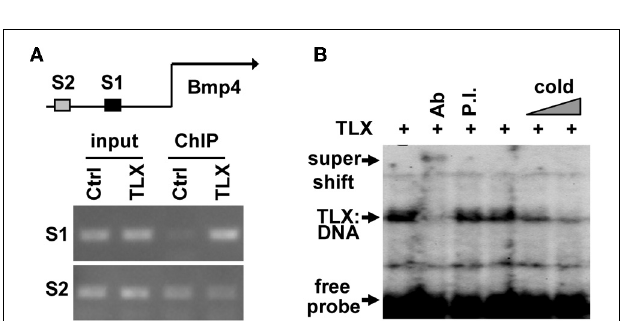
FIGURE 2 | TLX regulates genes involved in BMP signaling. (A) RNA-Seq analysis of gene expression from sorted P21 Nes -GFP + cells. (B) qRT-PCR analysis of selected genes using independent total RNA samples from sorted Nes -GFP + cells. The expression of Sox2 and Nes does not change.